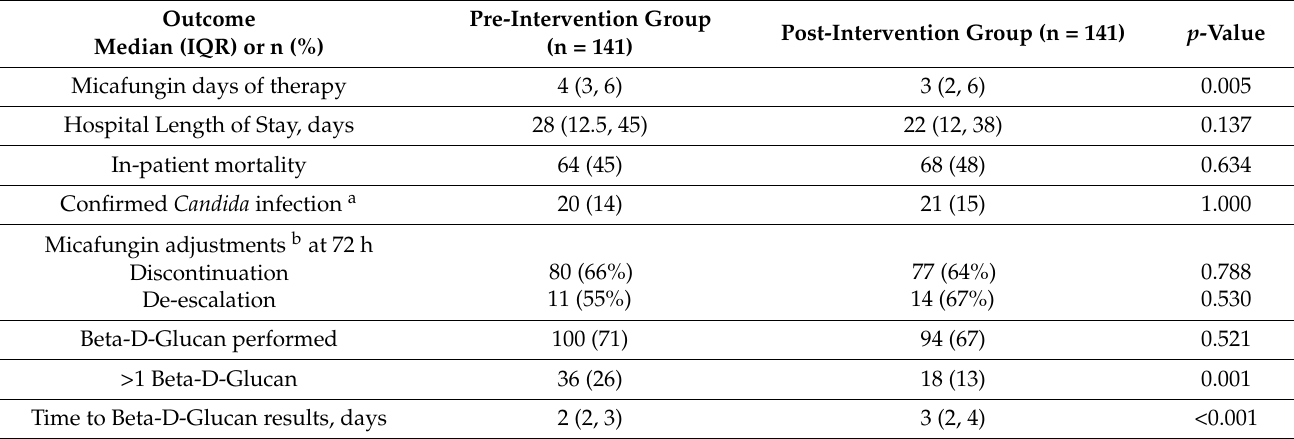
Table 2. Primary and Secondary